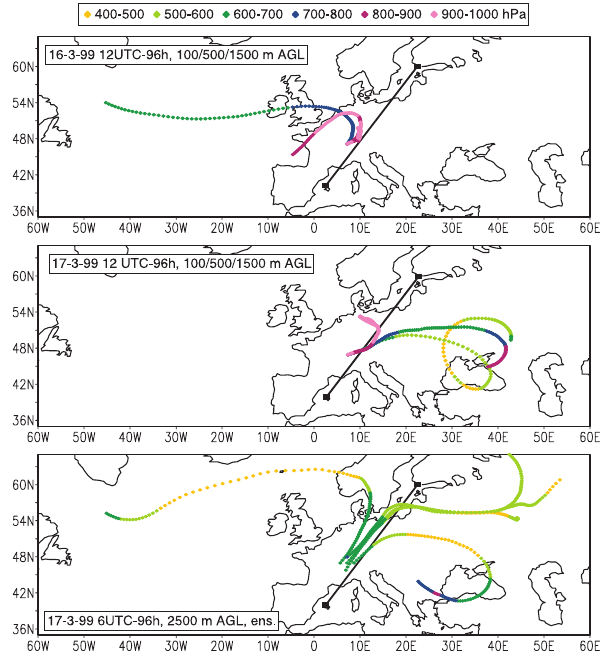
Fig. 11. 96-h backward trajectories from HYSPLIT/FNL arriving at Kerzersmoos at different altitude on 16 March, 12 UTC (top) and on 17 March, 12 UTC (centre), and ensemble of backward trajecto- ries arriving at Kerzersmoos on 17 March, 6 UTC at 2500 m above ground (bottom). The line indicates the cross section used in Fig. 15.